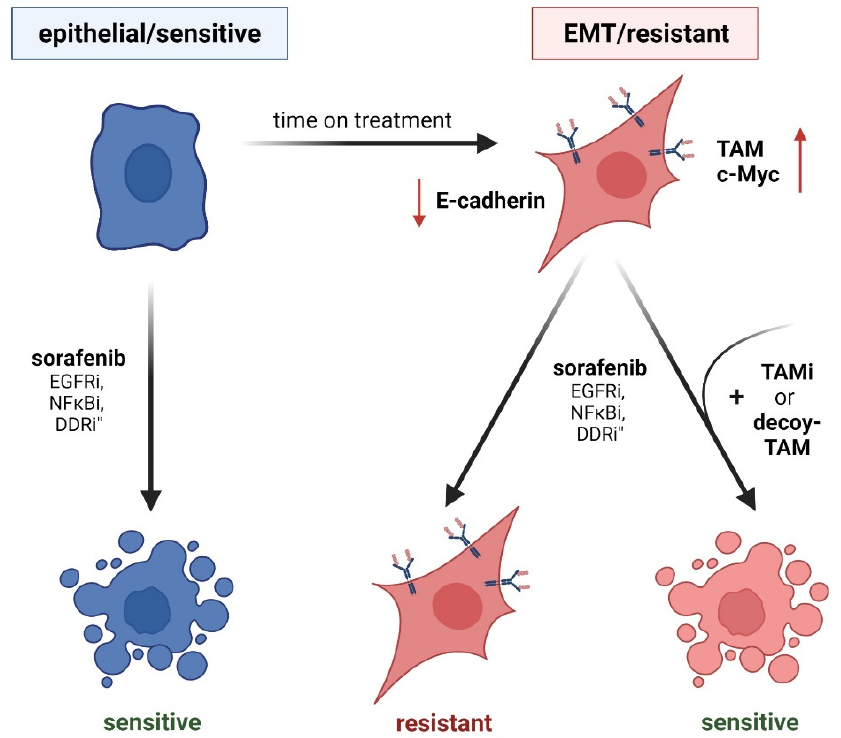
Figure 3. TAM receptor function in EMT and acquired chemoresistance. (Left panel) Epithelial cancer cells show sensitivity against drug treatment. EGF-Ri, inhibition of epidermal growth factor receptor; NF κ Bi, inhibition of nuclear factor κ B; DDRi, inhibition of DNA damage response. (Right panel) EMT-transformed cancer cells having reduced levels of E-cadherin (red arrow) exhibit higher resistance to drug treatment by induced TAM expression (right panel). Inhibition of individual TAM receptors (TAMi) or treatment with soluble TAM decoy receptors that bind TAM ligands restore chemosensitivity.